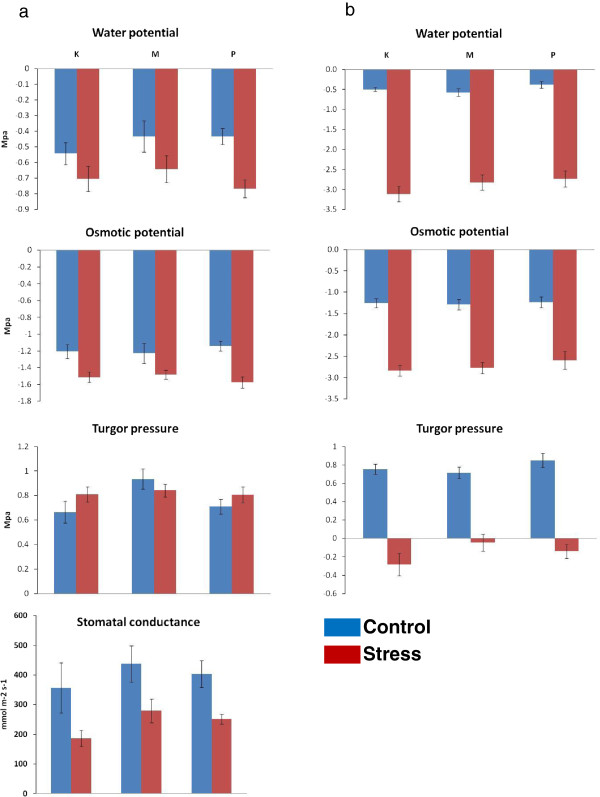
Leaf water relations and stomatal conductance in response to water deficit. a). Readings taken 30 days after stress treatment (sampling 1); b). Readings taken 52 days after stress treatment (sampling 2). Stomatal conductance was measured 10 days after stress treatment. Error bars are standard errors of mean (SEM).K–Katherine; M-Mt Isa; P-Petford.